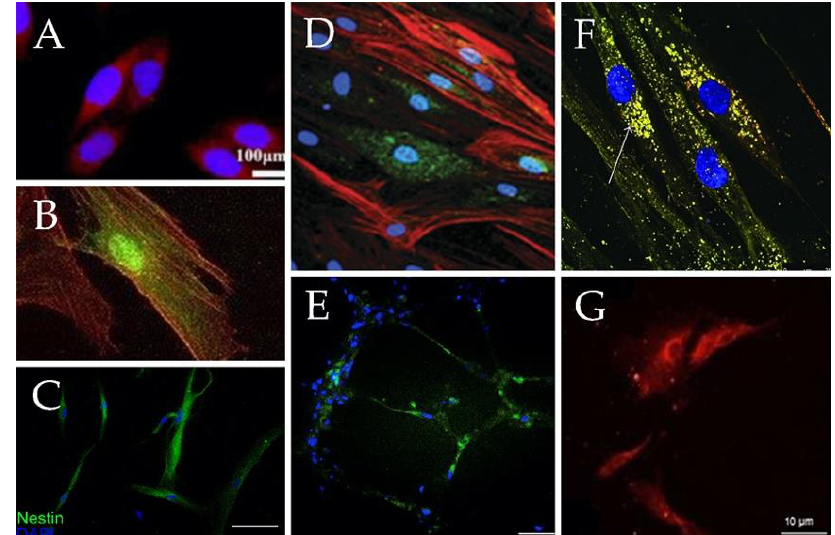
Figure 2. Immunofluorescent staining of MSCs differentiated into different cell types. ( A ) Hepatic differentiation of umbilical cord MSCs confirmed by the expression of hepatocyte-specific gene, cytochrome P450 3A4 (red). Scale bar, 100 µm (adapted from Reference [50]). ( B ) Cardiogenic differentiation of adipose tissue derived MSCs confirmed by the expression of sarcomeric-alpha-actinin (red) (adapted from Reference [34]). ( C ) Expression of Nestin (green) following neural induction of skin derived MSC. Scale bar, 100 µm (adapted from Reference [51]). ( D ) Epithelial differentiation of lung-MSCs after retinoic acid treatment, confirmed by the expression of E-cadherin (green) and anti-smooth muscle actin (red) (adapted from Reference [52]). ( E ) Endothelial differentiation of bone marrow derived MSCs confirmed by the expression of CD31 (green). Scale bar, 1 mm (adapted from Reference [53]). ( F ) Beta cells differentiation of bone marrow derived MSCs confirmed by the co-expression of insulin and c-peptide (yellow). Scale bar, 25 µm (adapted from Reference [54]). ( G ) Epidermal differentiation of umbilical cord MSCs confirmed by the expression of KRT5 (red). Scale bar, 10 µm (adapted from Reference [48]).